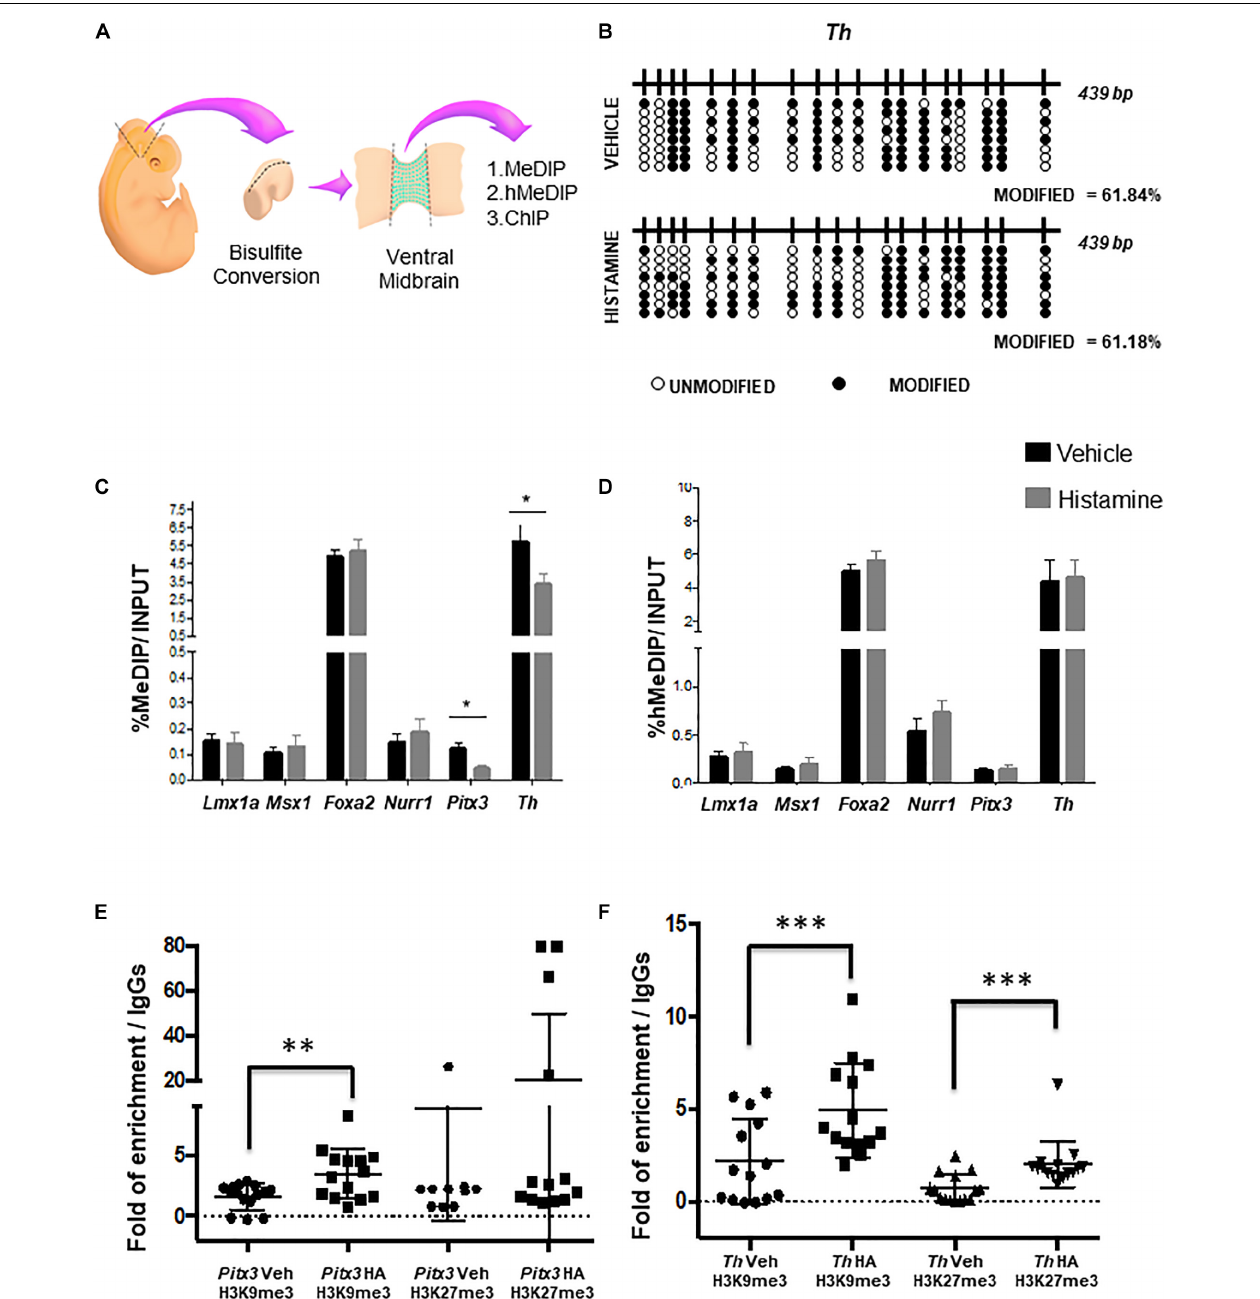
FIGURE 2 | Epigenetic modifications caused by HA in utero . (A) Scheme of the experimental design to dissect the midbrain and its ventral portion delimited by Lmx1a-positive cells, for the indicated analyses. (B) No changes were detected on modified cytosines, using sodium bisulfite and sequencing after HA administration in the MB, 2 days after intrauterine injection. Black circles represent modified CpGs, and white circles represent unmodified CpGs. (C,D) Enrichment analysis of 5-methylcytosine and 5-hydroxymethylcytosine in different genes involved in DA differentiation. qPCR analysis on DNA after immuno-precipitation with anti-5mC ( C , MeDIP) and anti-5hmC ( D , hMeDIP) antibodies in HA- or vehicle-injected embryos. Internal negative and positive controls were performed according to the manufacturer’s specifications (Diagenode; mc-magme-048). Data was normalized against 10% INPUT. Chromatin immunoprecipitation analysis of H3K9me3 and H3K27me3 levels in Pitx3 (E) and Th (F) genes. The box plots represent the qPCR amplifications of the fourth exon of Pitx3 and the first exon Th , using the DNA obtained from the ChIP assay employing anti-H3K9me3 and anti-H3K27me3 antibodies, in tissue treated with either vehicle or HA. As a negative control, we used the IgG antibody included in the OneDay ChIP kit (Diagenode, NJ, United States, Kch-onedIP-180). ∗ p < 0.05, ∗∗ p < 0.01, ∗∗∗ p < 0.005 compared to the vehicle-treated tissue from 3 (B) to 4 (C–F) independent experiments.